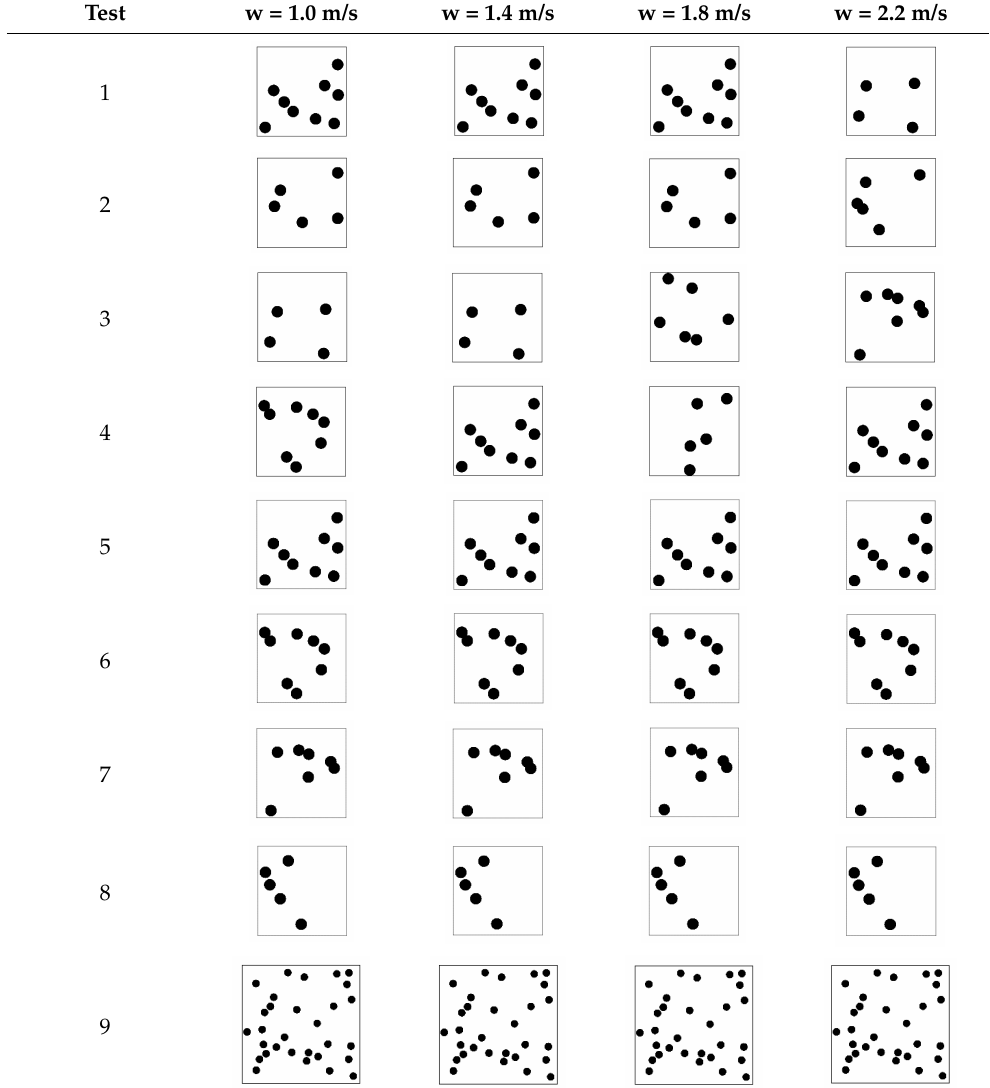
Table 1. Top views of the simulated domain showing the initial positions of the drops in all the performed simulations about multiple